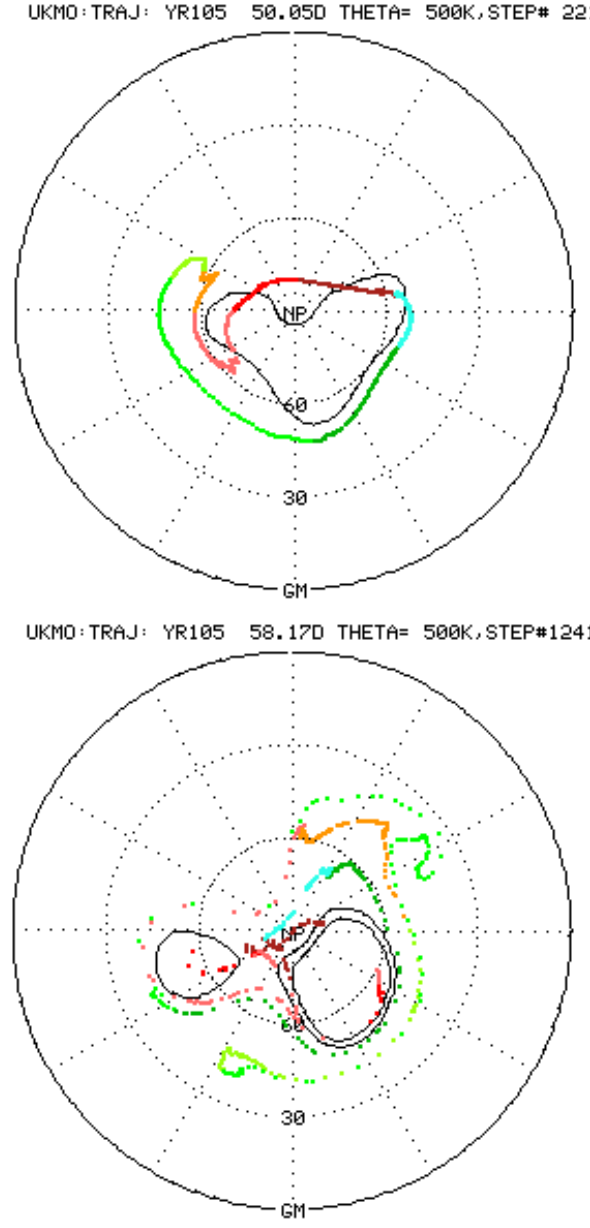
Fig. 15. Trajectory analyses at 500K/ ∼ 20km for two days (19 February and 27 February) within the 25 February tempera- ture/vortex disturbance event of winter 2004/2005. Air parcels were released at the 60 ◦ N circle on 17 February: burgundy red at 16 ◦ E and middle/bright green at 253 ◦ E. The vortex edge (from the Q- diagnostic) is shown by the black